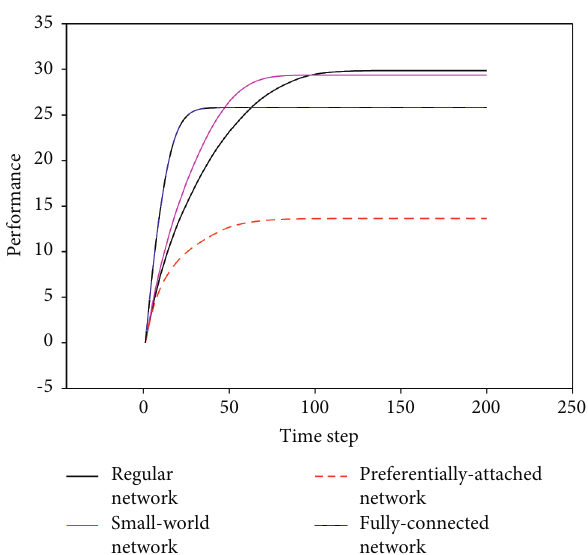
Figure 4: Locomotion learning in different network structures.